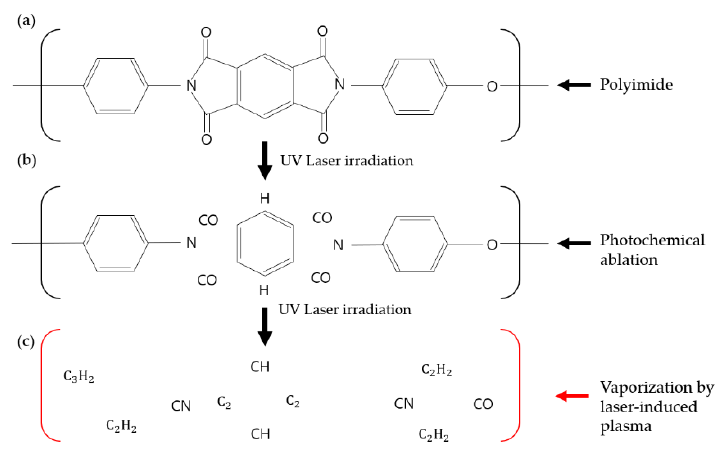
Figure 2. Principle of laser-induced plasma (LIP), using a 355 nm pulsed laser: ( a ) polyimide structure,